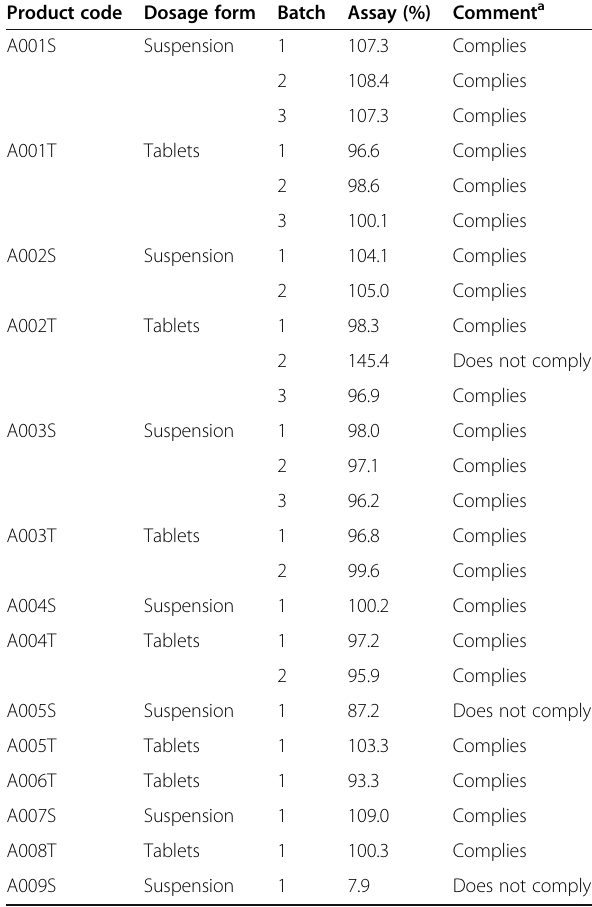
Table 3 Results of analyses of commercial products for albendazole